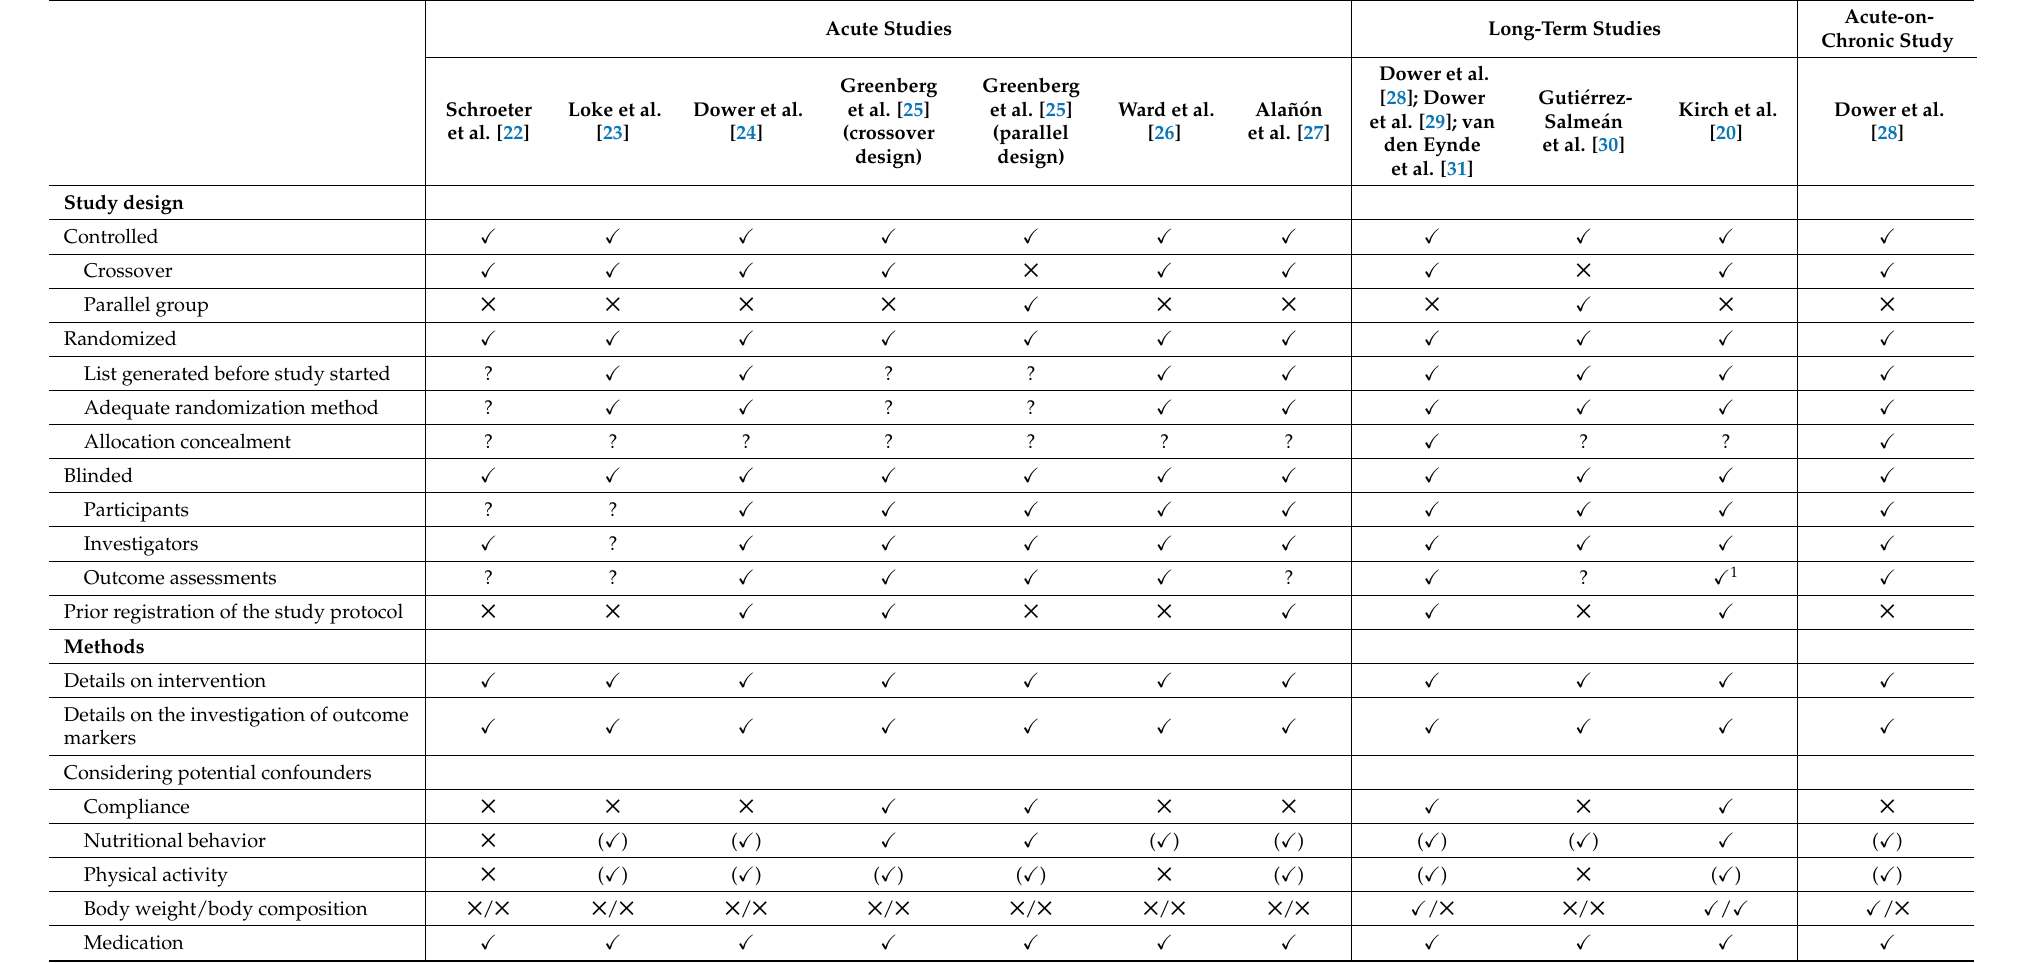
Table 4. Criteria on studies’ quality to assess the risk of